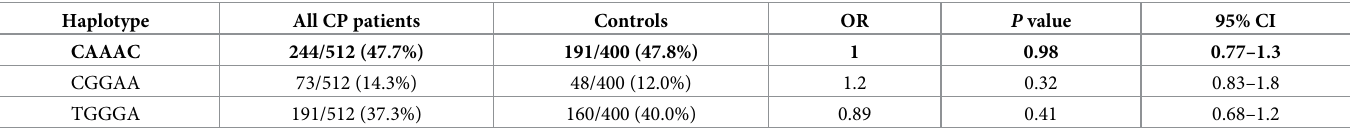
Table 10. Distribution of common PNLIPRP2 haplotype alleles in patients with chronic pancreatitis (CP) and in